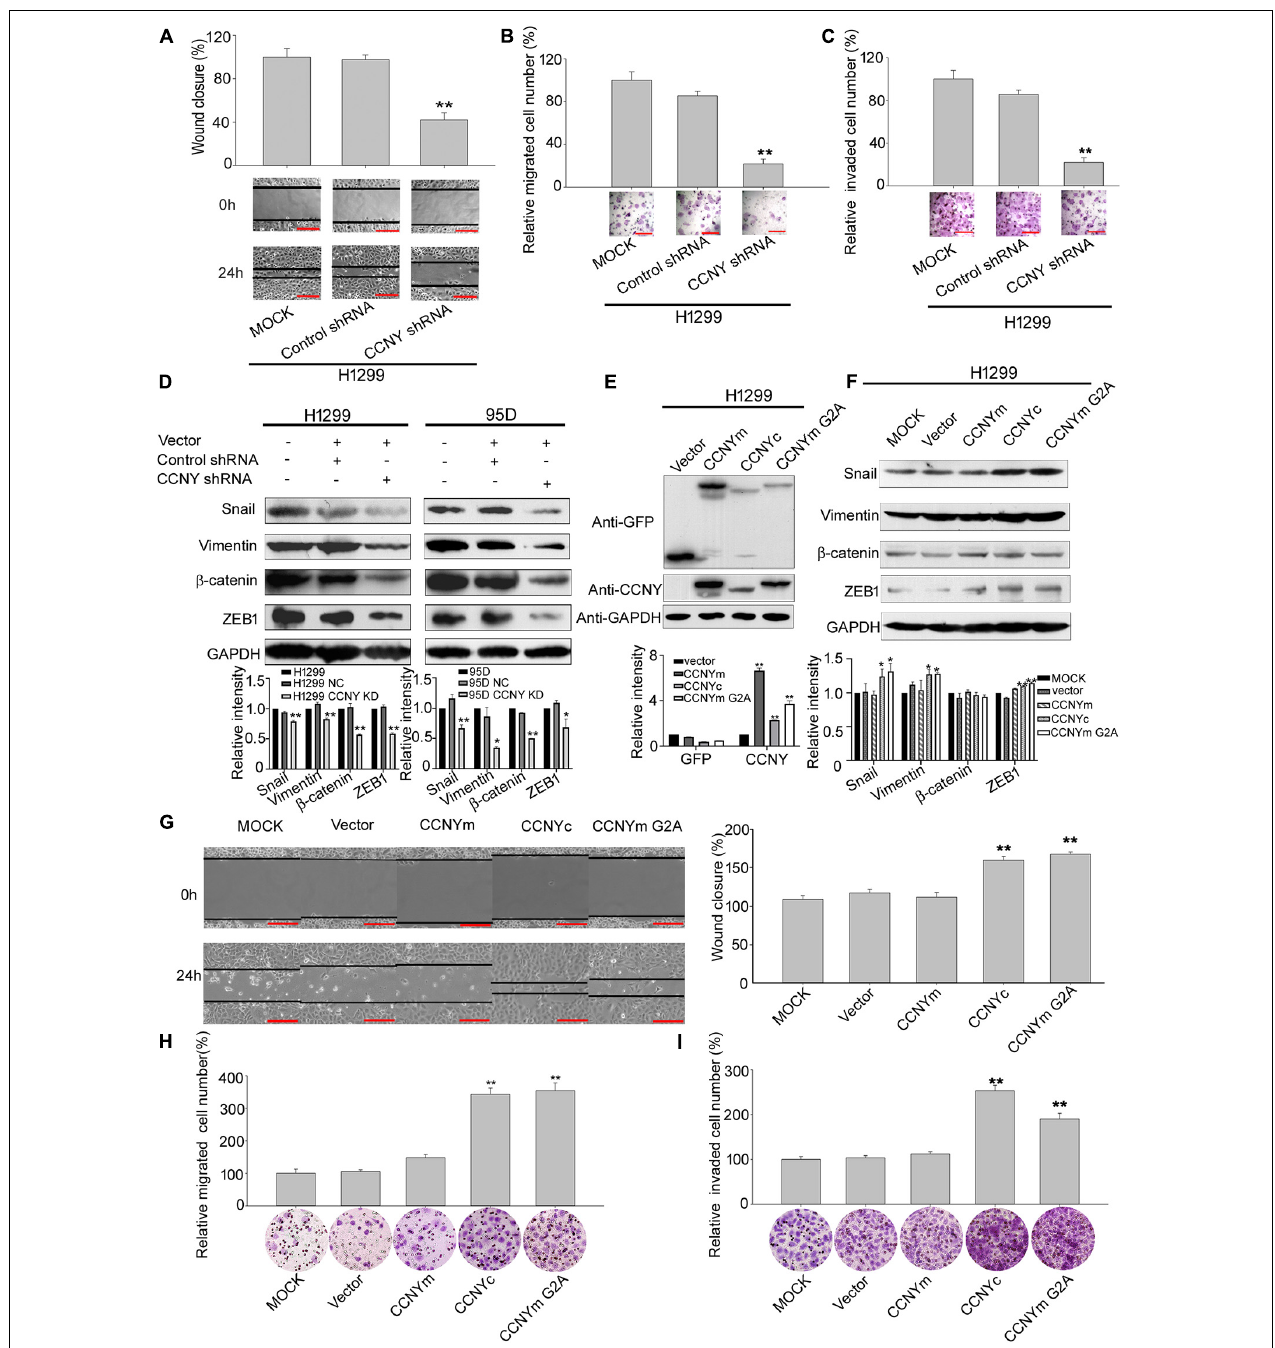
FIGURE 3 | CCNYc could promote cell motility and invasiveness in H1299 cells. (A) Wound healing assay performed with H1299-CCNY KD and control cells over 24 h. The migration activity is shown as mean ± SEM. Bars represent 200 µ m. ** p < 0.01 vs. NC cells ( t -test, N = 3). (B,C) Transwell assay performed with H1299-CCNY KD and the control cells. Cells migrated or invaded through the membrane were calculated and standardized. Bars represent 200 µ m. ** p < 0.01 vs. NC cells ( t -test, N = 3). (D) The upper panel, levels of β -catenin, vimentin, ZEB1 and snail were measured by WB; the lower panel, the level of proteins was quantified by gray analysis. * p < 0.05 vs. NC cells, ** p < 0.01 vs. NC cells ( t -test). (E) Expression levels of GFP and CCNY were examined by immunoblotting. The levels of GFP and CCNY were quantified by gray analysis in the lower panel. ** p < 0.01 vs. H1299- pEGFP-N1 cells ( t -test). (F) Expression of ZEB1, vimentin, β -catenin and snail were examined by WB. The quantification of the proteins was listed in the lower panel. * p < 0.05 vs. H1299-vector cells, ** p < 0.01 vs. H1299-pEGFP-N1 cells ( t -test). (G) Wound healing assay performed with CCNYm, CCNYc, and CCNYm G2A upregulation cells. The migration activity is expressed as mean ± SEM. ** p < 0.01 vs. H1299 cells transfected with pEGFP-N1 vector ( t -test, N = 3). (H,I) Transwell migration assay and invasion assay were used. Bars represent 200 µ m. The data are shown as mean ± SEM. ** p < 0.01 vs. H1299 cells transfected with pEGFP-N1 vector ( t -test, N = 3).